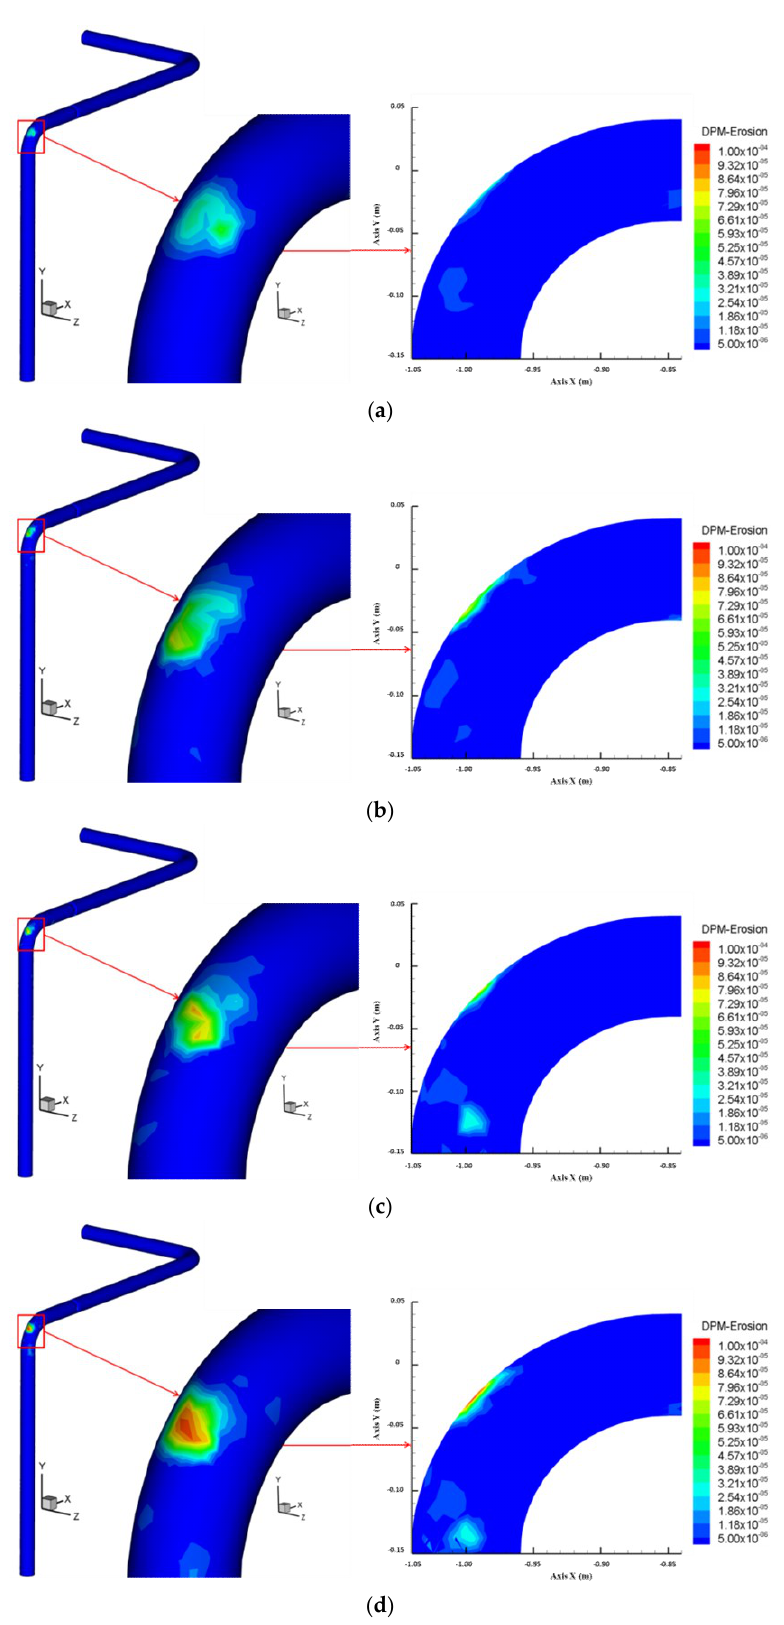
Figure 10. Erosion rate contours of gas–solid two-phase flow pipeline under different openings of the throttle valve. ( a ) 20% of the throttle valve opening ( C = 20%); ( b ) 30% of the throttle valve opening ( C = 30%); ( c ) 40% of the throttle valve opening ( C = 40%). ( d ) 50% of the throttle valve opening ( C = 50%).